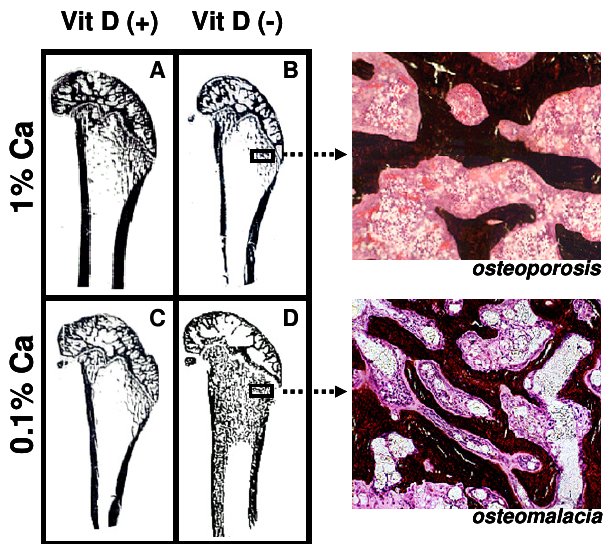
Figure 3. Longitudinal sections (Von Kossa stained) of 9-month old Sprague-Dawley